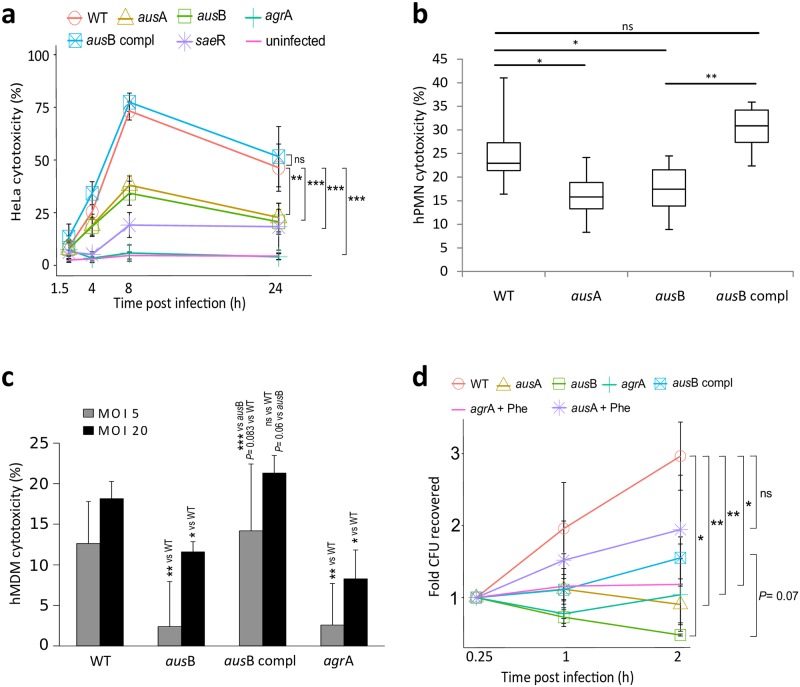

S. aureus aus mutants show altered virulence in epithelial cells and human neutrophils.
a) HeLa cells were left uninfected (control) or were infected with S. aureus JE2 wild type (WT), isogenic ausA and ausB mutants, a complemented ausB mutant (ausB compl), or mutants within the virulence regulators agrA and saeR. Kinetics of cytotoxicity was monitored over time (x-axis) by propidium iodide (PI) staining and flow cytometry (y-axis; HeLa cytotoxicity in %). The agrA mutant did not demonstrate detectable host cell death. saeR, ausA and ausB mutants were significantly diminished in their ability to kill host cells. Genetic complementation of ausB recovered the phenotype of the insertional mutant. The apparent reduction of cytotoxicity at 24 hours p.i. is mediated by extended fragmentation of cells, which therefore are outside of the FSC-SSC gate for viable cells. Statistical analysis was performed by linear modeling and ANOVA followed by Tukey’s post-hoc analysis; ***P < 0.001 (Wt vs. ausA or ausB; 8 h p.i.). Host cell death rates are reduced in (b) hPMN 4 hours p.i. or(c) primary human monocyte-derived macrophages (hMDM) 2 hours p.i. when the phagocytes were infected with aus mutants. Cell death was measured by LDH release as percentage relative to the complete lysate (positive control) and supernatant of uninfected cells (set to 0% cell death, negative control). d) The NRPS AusAB is involved in bacterial survival upon macrophage co-incubation. CFUs of wild type (WT), insertional mutants within ausA, ausB and agrA were recovered at the indicated time points and numbers were normalized to the 15 min time point. Phevalin (+Phe) was added to selected samples at a concentration of 10 μM to assess complementation with the synthetic dipeptide. Graphs show the mean of at least three independent experiments ± SD. Statistical analyses were performed by t-test (b,c) and Wilcoxon rank sum test (d). *P < 0.05; **P<0.01; ***P < 0.001.